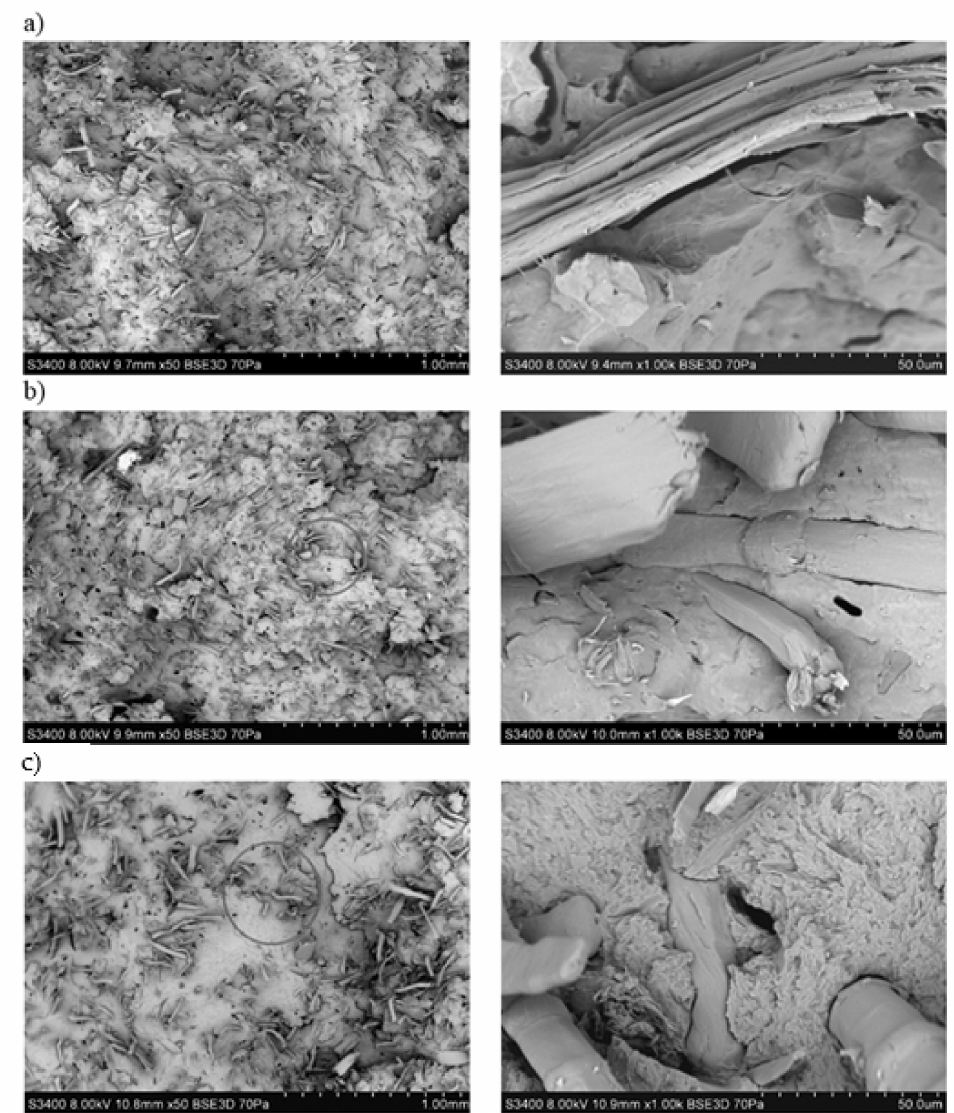
Figure 19. SEM photographs of fracture surface of biocomposite samples filled with flax fibers: ( a ) unmodified, ( b ) alkalized with 2% NaOH solution, ( c ) alkalized with 10% NaOH